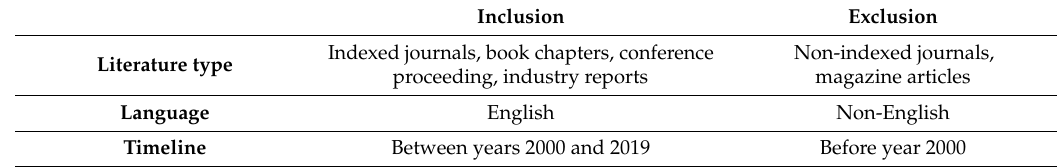
Table 2. Inclusion and exclusion